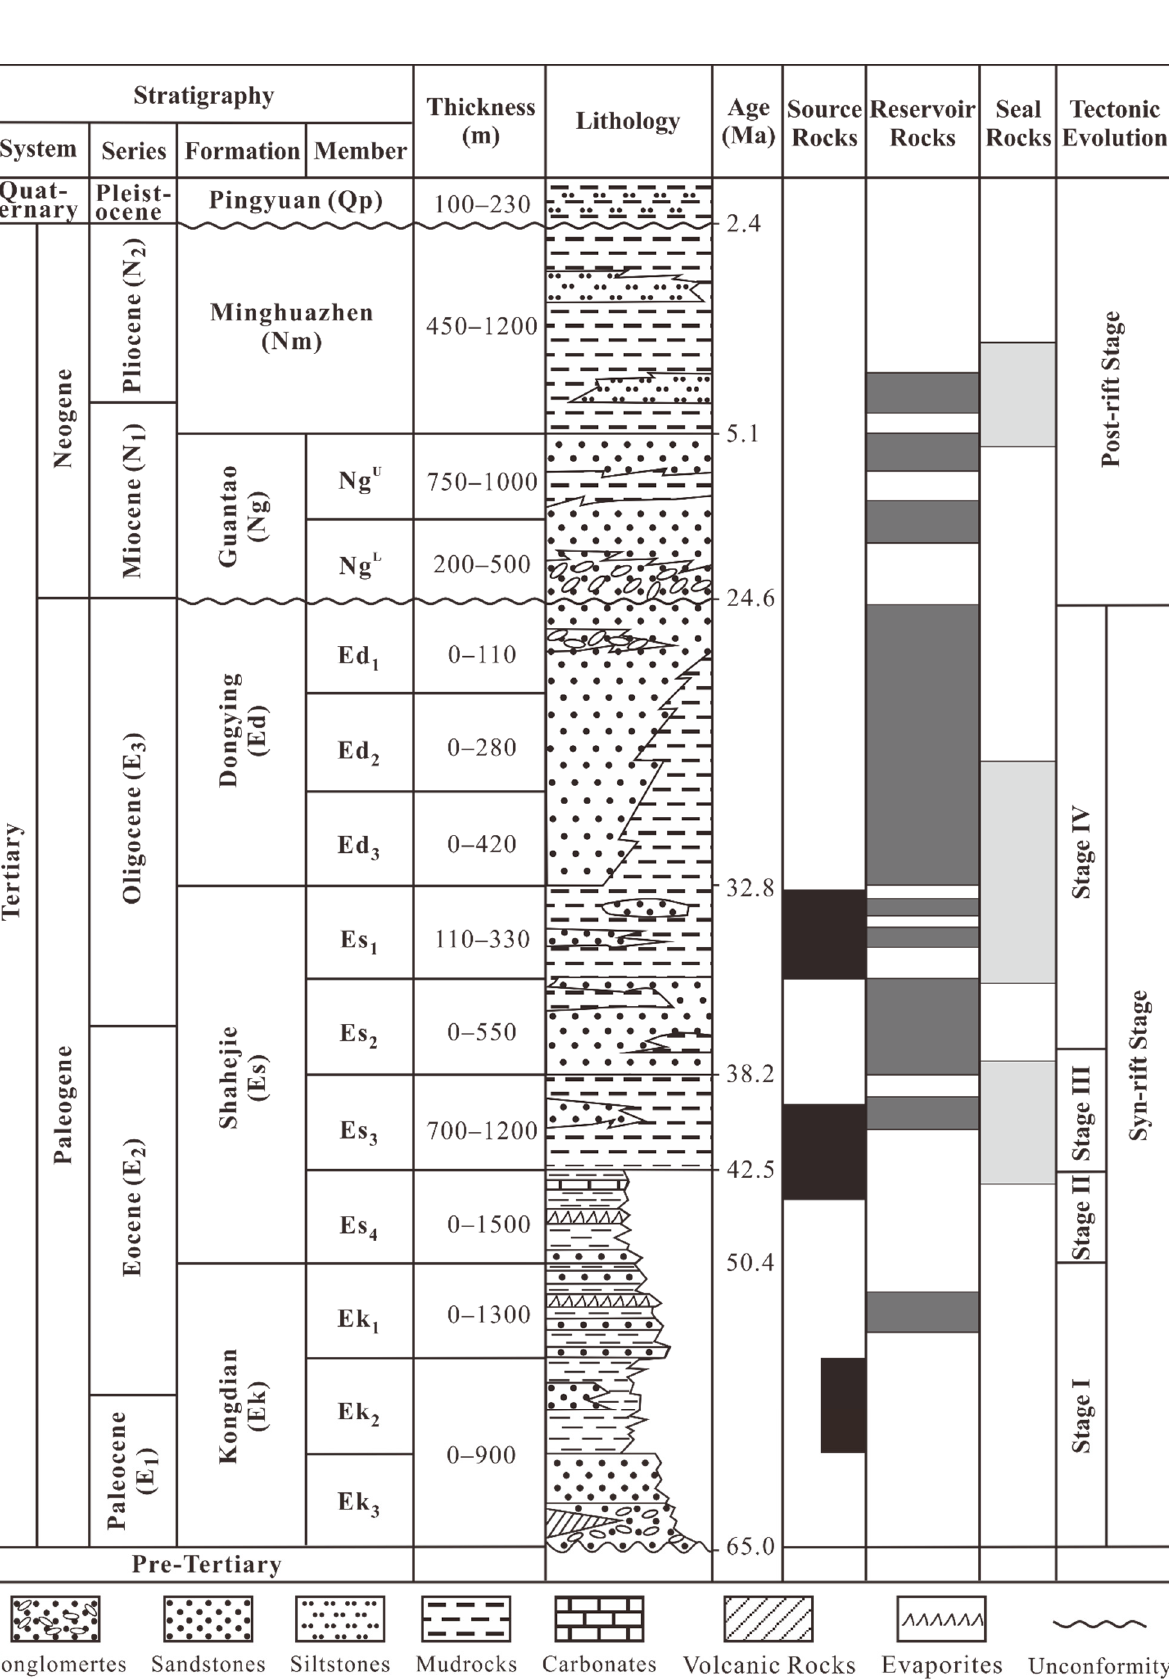
Figure 2. The Tertiary stratigraphy of the Dongying depression.